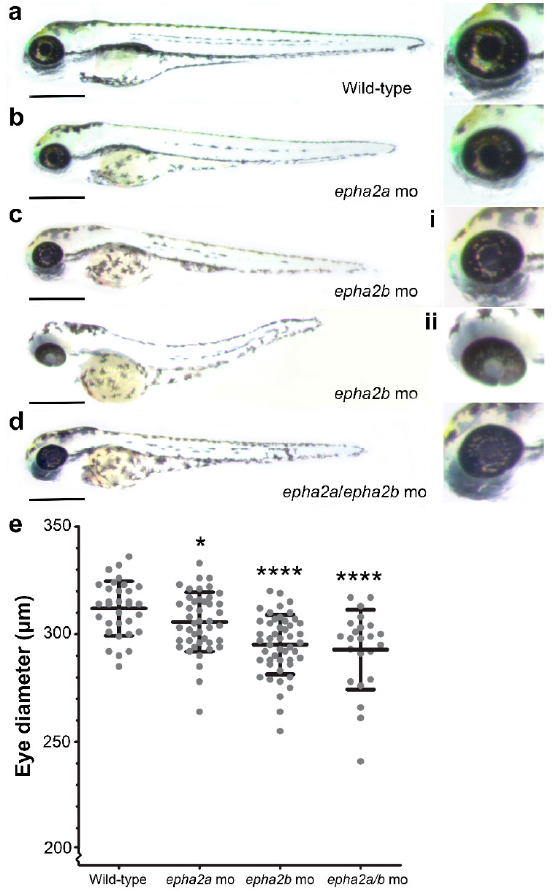
Figure 3. Reduced eye size in epha2a and epha2b morphant zebrafish. ( a ) Uninjected wild-type control embryos at 3 dpf; ( b ) morpholino knockdown of epha2a , ( c ) epha2b, and ( d ) epha2a / epha2 b resulted in reduced eye size. Variable phenotype was seen with epha2b morphants, some with milder (i) or more severe eye (ii) features including lens opacification and coloboma. ( e ) Eye diameter measurement at 3 dpf showed a significant decrease in epha2a , epha2b and epha2a / epha2b morphants compared to uninjected wild-type controls. Unpaired t-tests were used to compare data. * p < 0.05, **** p < 0.0001. Scale bar = 500 µ